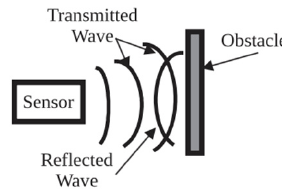
Figure 3. Obstacle detection based on reflection of a sound wave from an ultrasonic sensor. Reprinted with permission from Ref. [31]. Copyright 2018, IEEE